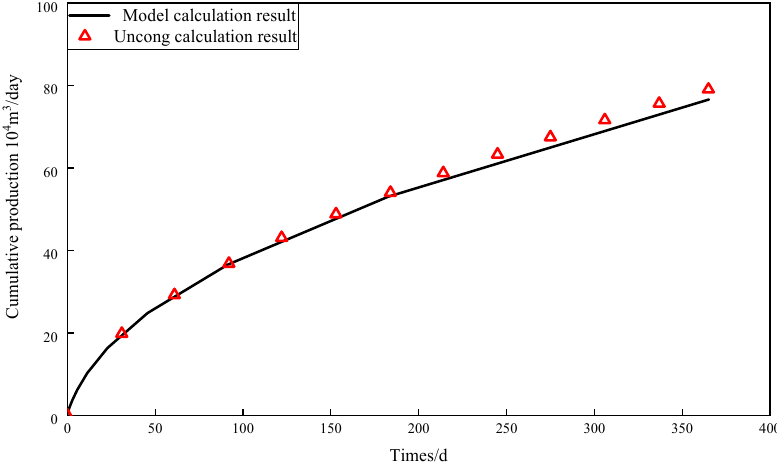
Figure 4. Cumulative production (model vs. Uncong).